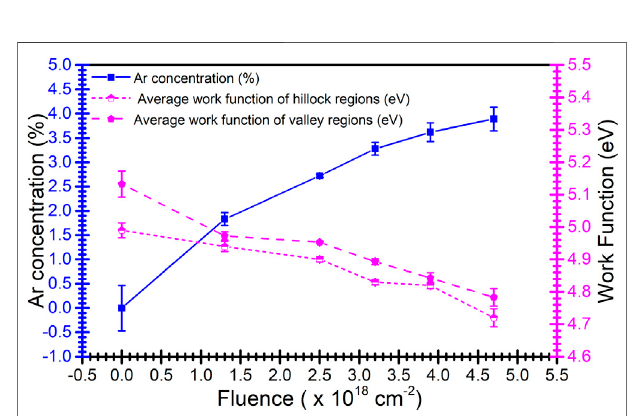
FIGURE 6 | Variation of argon concentration (calculated from XPS data) and variation of the work function distributed over mounds (microhill regions) and relatively fl at regions (obtained from KPFM data) with ion beam fl